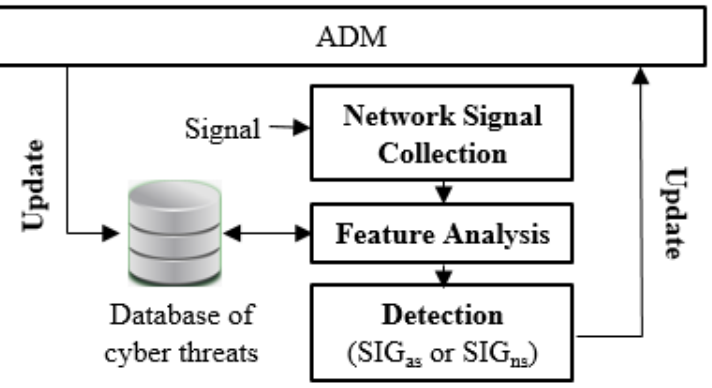
Figure 3. ADM (Anomaly Detection Model).